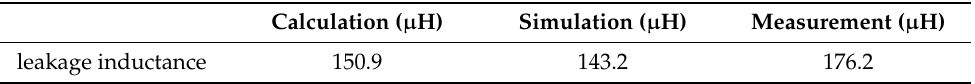
Table 2. Calculation, simulation, and measurement results of transformer leakage inductance.